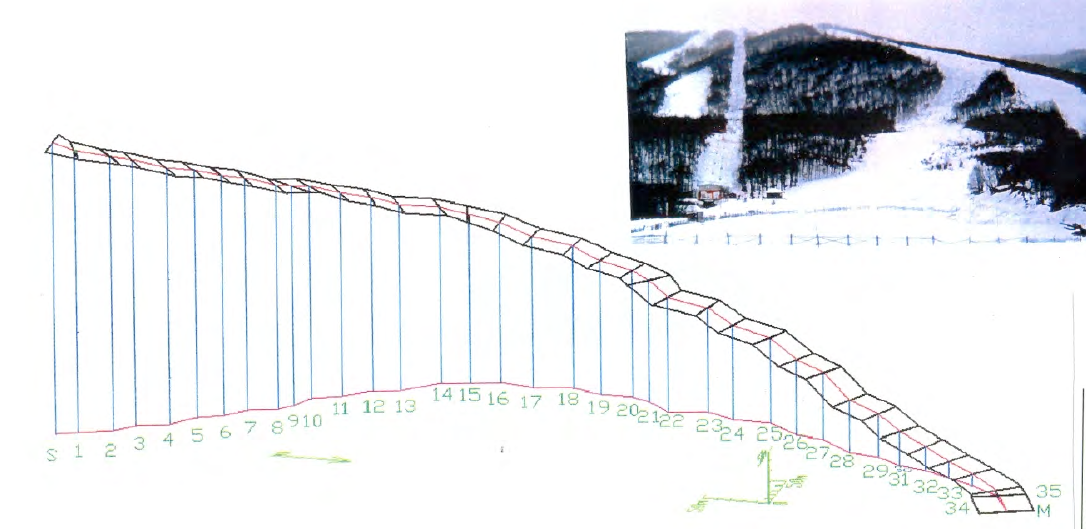
Figure 5. Topographic shape of the giant slalom course in racing conditions on snow and 35 gates in Naussa